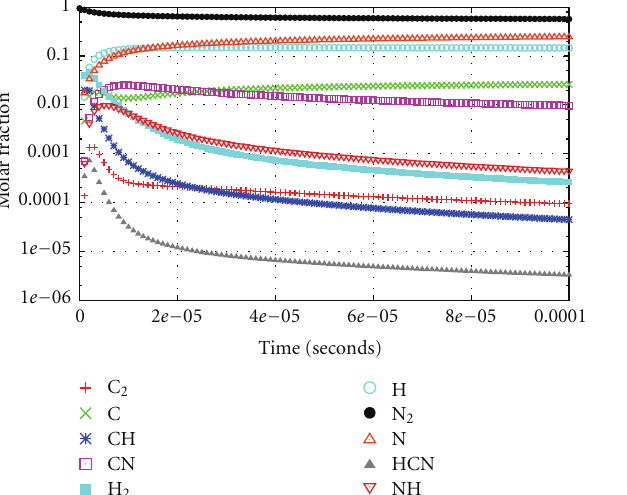
Figure 6: Ions-reduced model.